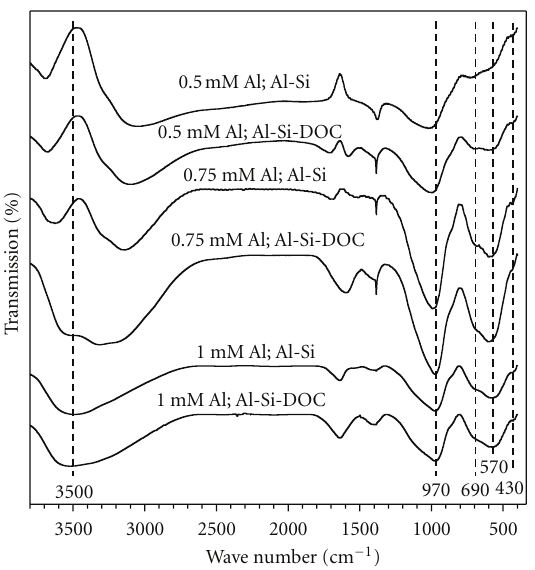
Figure 4: FTIR spectra for solids derived from Al-Si and Al-Si-DOC solutions with 0.5, 0.75 and 1.0mM Al; 0.5mM Si; and 0 or 6mg/L DOC.